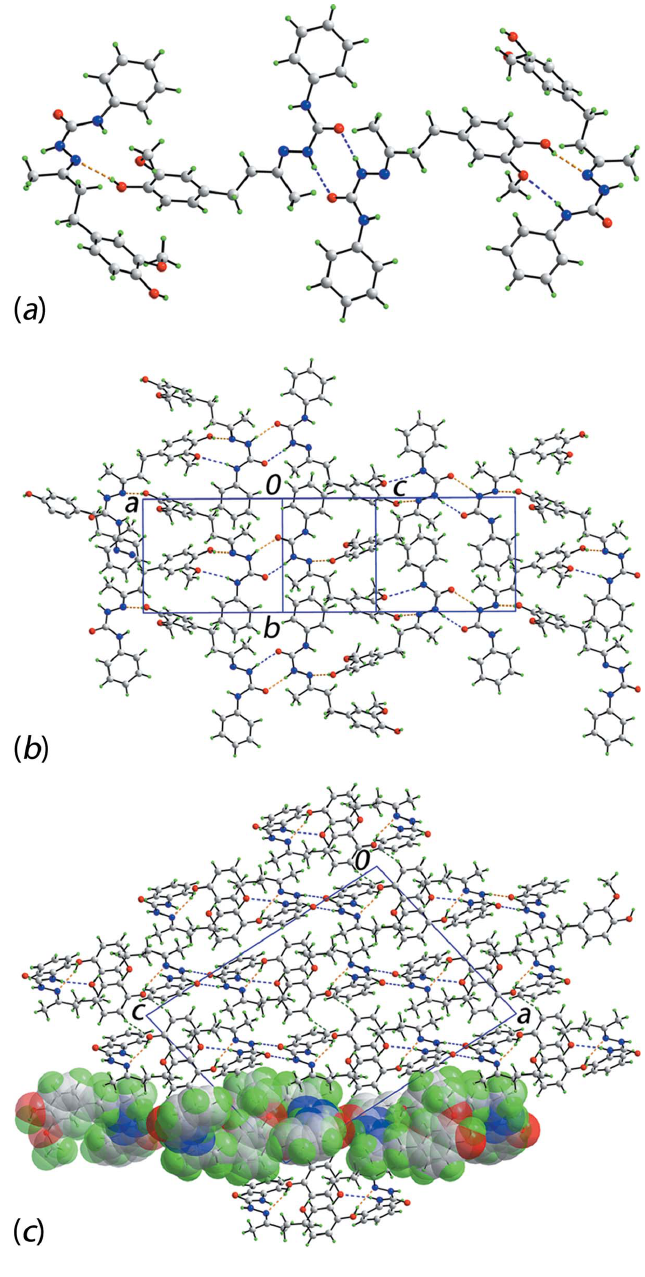
Figure 3 The molecular packing in (I): ( a ) a detail of the supramolecular association sustained by O—H (cid:3)(cid:3)(cid:3) N and N—H (cid:3)(cid:3)(cid:3) O hydrogen bonding, shown as orange and blue dashed lines, respectively, ( b ) a view of the supramolecular layer in the ac plane, and ( c ) a view of the unit-cell contents shown in projection down the b axis. The C—H (cid:3)(cid:3)(cid:3) O interactions are shown as green dashed lines, and one layer is highlighted in space- filling mode.